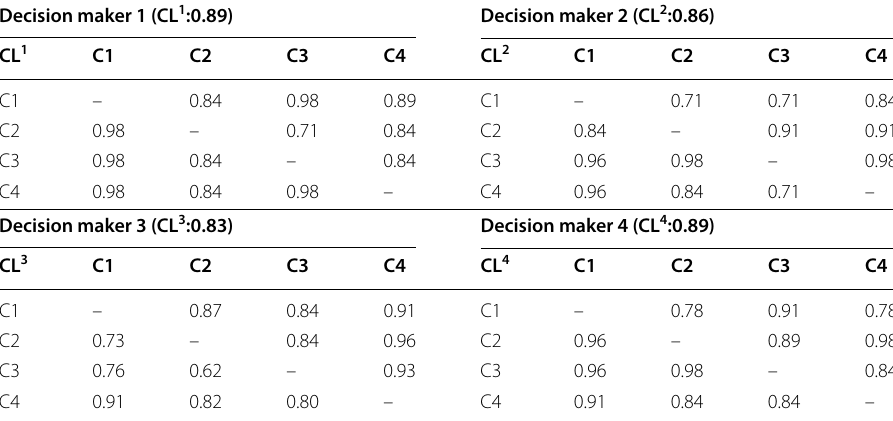
Table 7 Decision-makers’ consistency levels for revenue sharing model